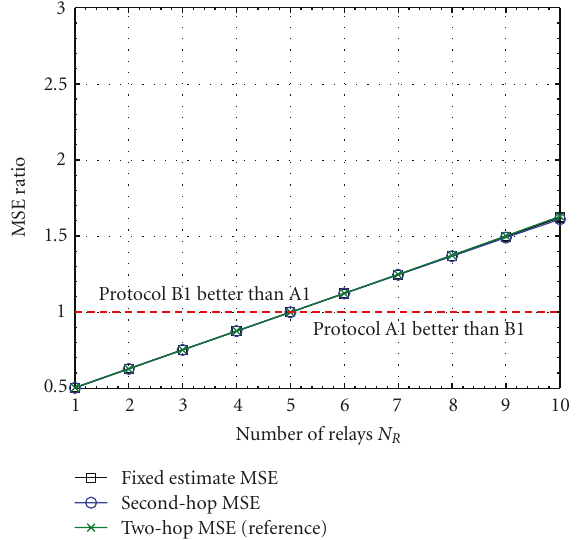
Figure 4: MSE ratios (see page 23) versus N R for τ = 1, SNR est = = 10 − 2 . 20dB, and σ 2 pn